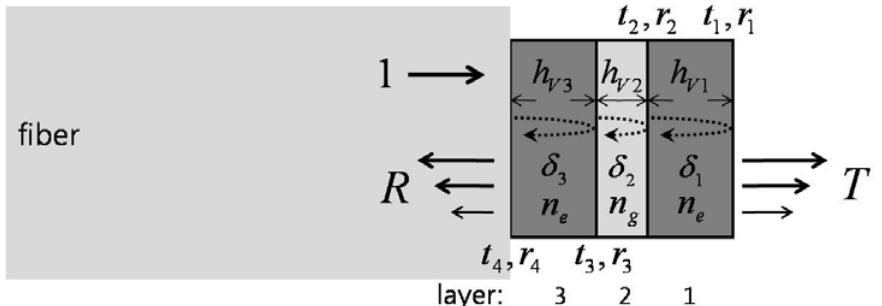
and δ , respectively). 1 3